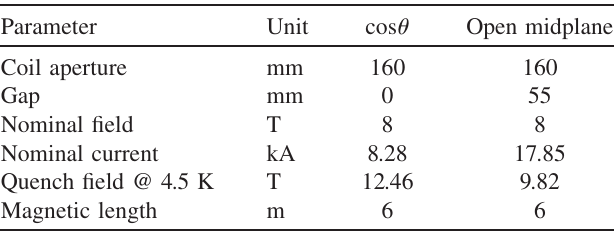
TABLE IV. IR dipole parameters.